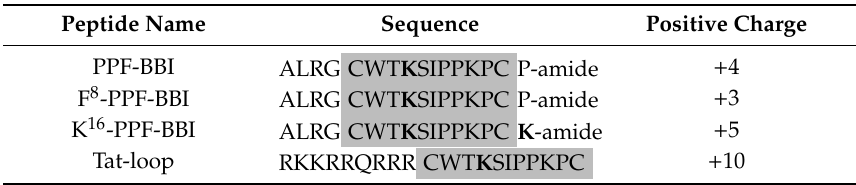
Table 1. The sequence and positive charge of Pelophlax plancyi fukienesis Bowman-Birk-type inhibitor (PPF-BBI) and its rational design analogues.